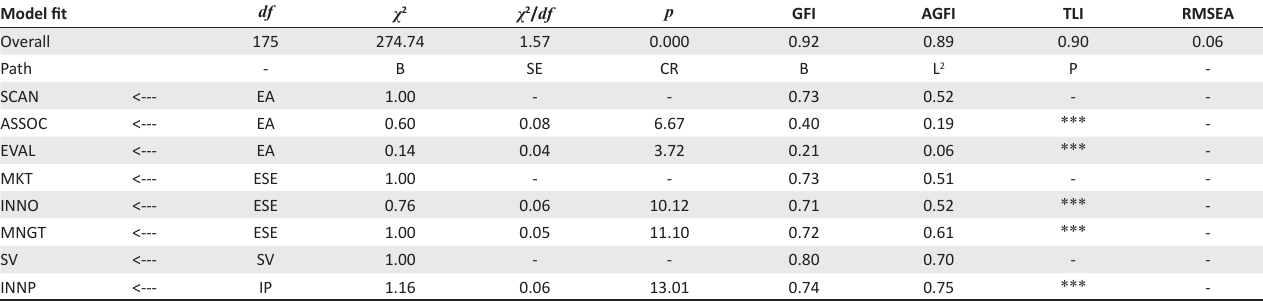
TABLE 1: Statistics for the hypothesised measurement model (confirmatory factor analysis results). Model fit